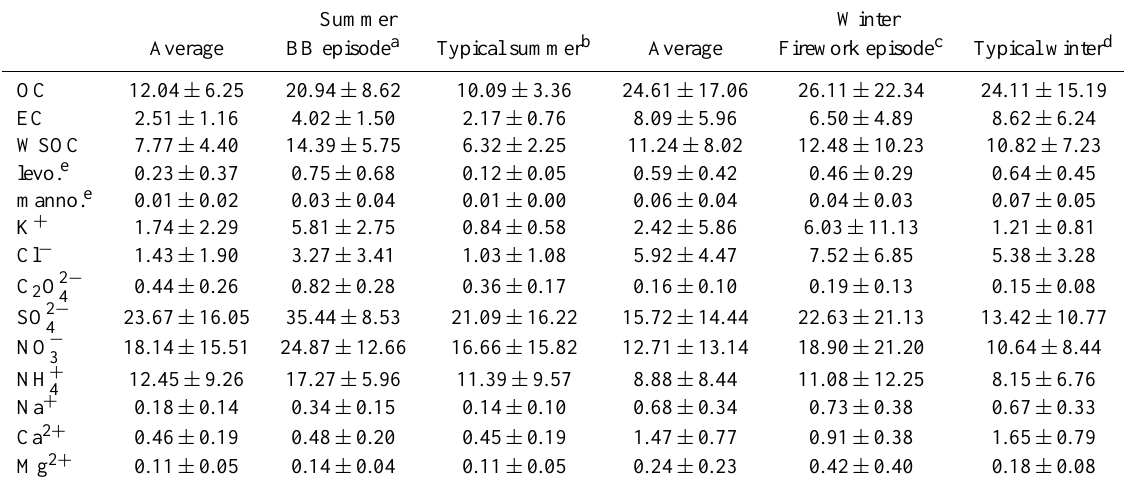
Table 1. Average concentrations of PM 2 . 5 components during summer and winter in Beijing. Values of OC, EC and WSOC are presented in µgCm − 3 , whereas concentrations of the other species are presented in µgm − 3